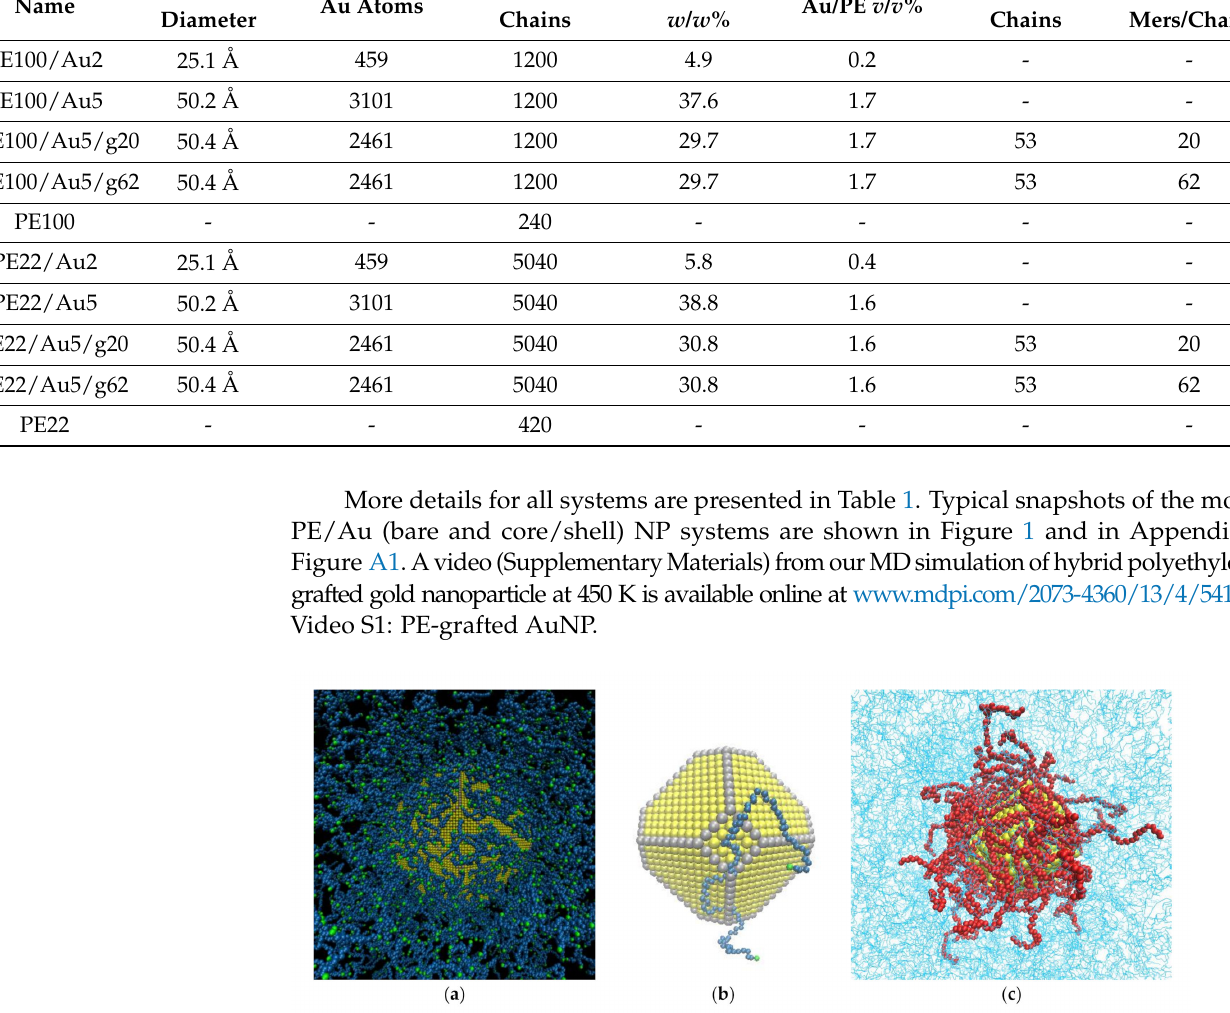
Figure 1. Snapshots from the model systems: ( a ) The PE22/Au5 hybrid system. In yellow is the Au, in blue are the CH 2 monomers and in green are the CH 3 monomers. ( b ) Au NP, of d = 5.02 nm (in yellow are the Au atoms and in grey the edge Au atoms), and a PE 100 mer chain. ( c ) The PE100/Au5/g62 hybrid system. In blue are the free CH 2 and the free CH 3 monomers. In red are the grafted CH 2 and CH 3